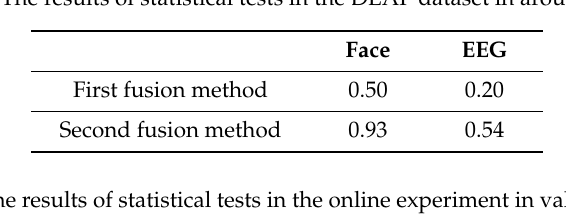
Table 7. The results of statistical tests in the DEAP dataset in arousal space.